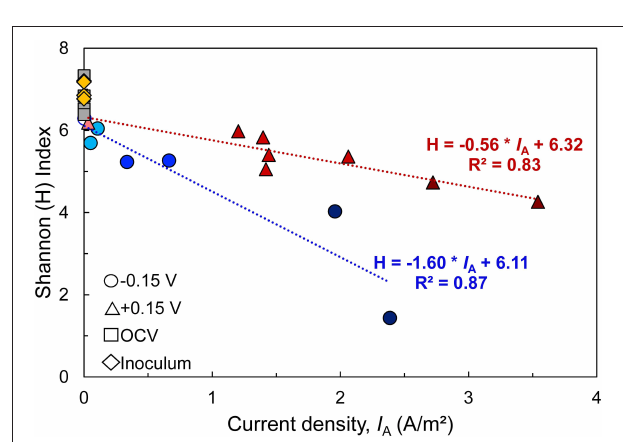
FIGURE 8 | Relationship between microbial diversity [estimated by the Shannon Diversity index (H)] and bioanode current density ( I A ) recorded at the end of the startup cycle. A higher H index represents a more diverse microbial community. Linear regression of replicates from each fixed potential are represented by dotted lines (blue: − 0.15V, red: + 0.15V), along with regression equation and coefficient of determination ( R 2 ). Points with the same shape represent replicate bioanodes fixed at − 0.15V (circles) and + 0.15V (triangles). The points are shaded to reflect bioanode activity level (dark, high-activity; medium, low activity; light, inactive). Communities from the wastewater inoculum are shown as yellow rhombi and the open circuit (OCV) controls are represented as gray